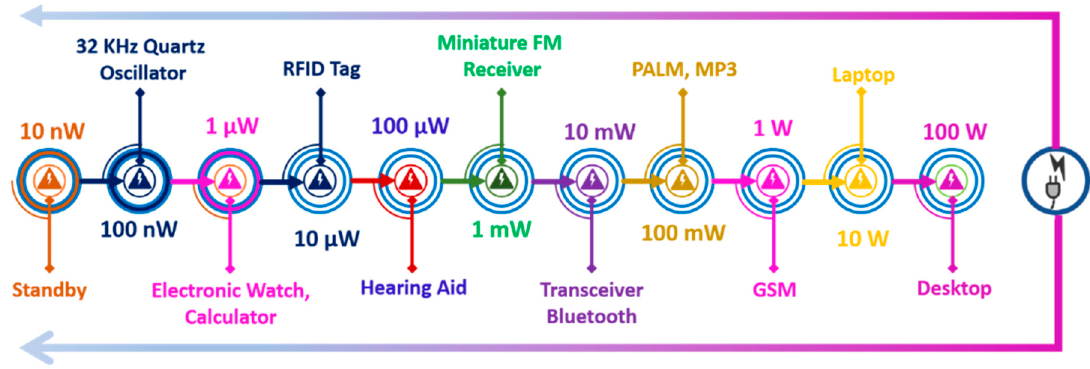
ff erent IoT sensors and devices (10 nW–100 W) Figure 3. Power requirements of different IoT sensors and devices (10 nW–100 W) [85–88]. Figure 3. Power requirements of di